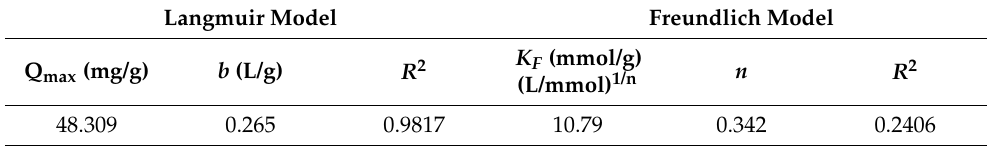
Table 3. Langmuir and Freundlich isotherm parameters for lead adsorption on HAP. Langmuir Model